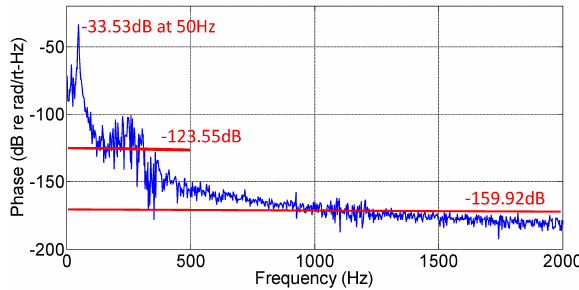
Figure 10. Noise of the geophone system output.